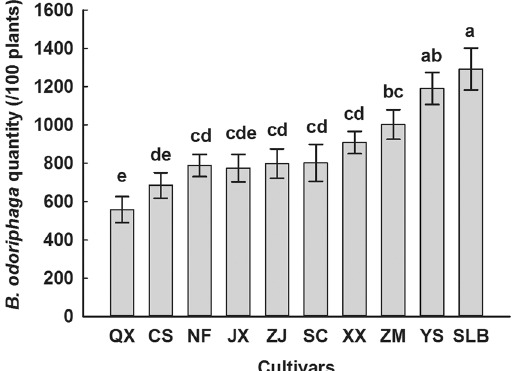
Figure 1. The quantity of Bradysia odoriphaga at different garlic cultivars in the field. The letter of QX, CS, NF, JX, ZJ, SC, XX, ZM, YS and SLB means the garlic cultivar of Qixian, Cangshan, Nanfang, Jinxiang, Zajiao, Sichuan, Xinxiang, Zhongmu, Yishui and Siliuban respectively. Values (quantity, mean ± s.e.) were analyzed with ANOVA, and different letters denoted significant differences by Tukey test ( P <